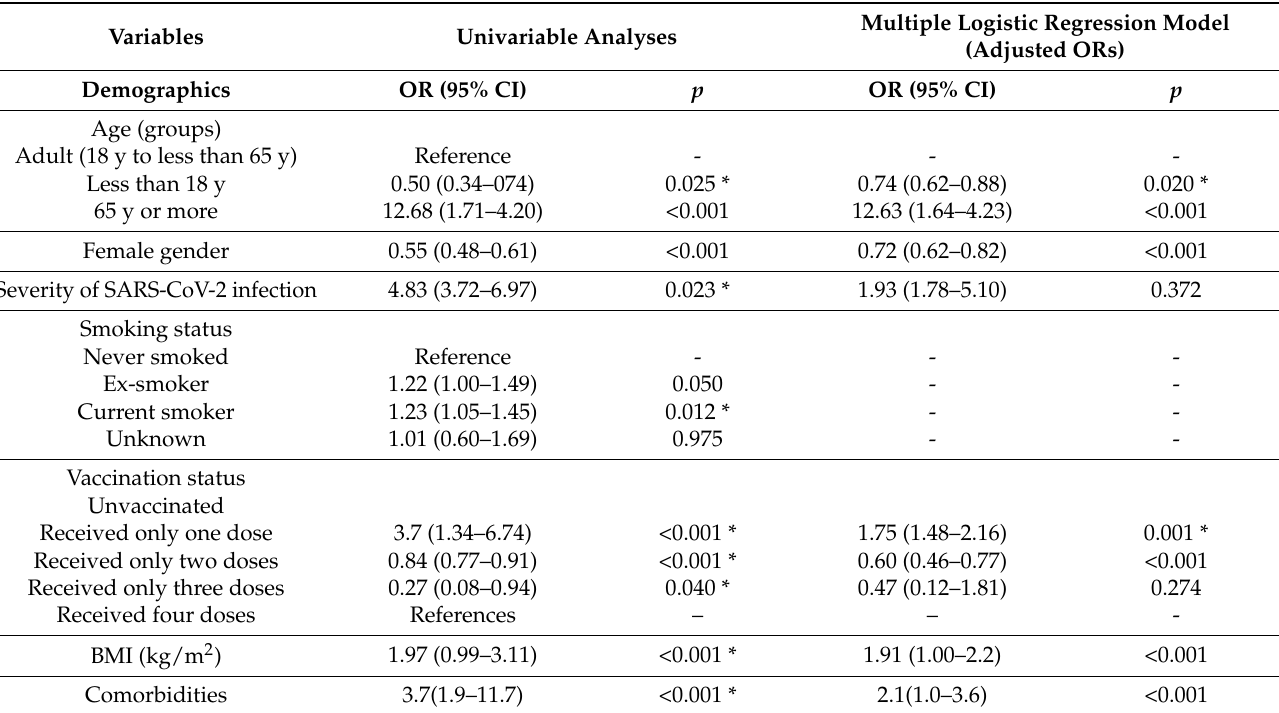
Table 5. Factors significantly associated with the participants’ reports of delayed return to pre- COVID-19 infection baseline health